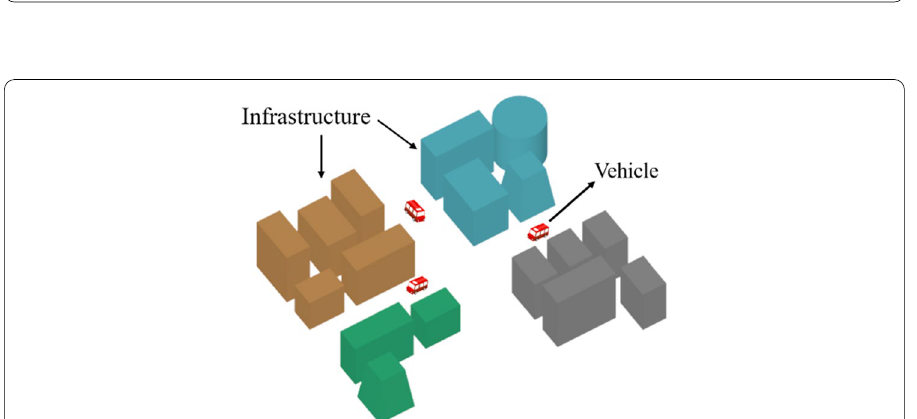
Fig. 14 The three-dimensional view of simulating distribution of electrical field for two automobile antennas in the